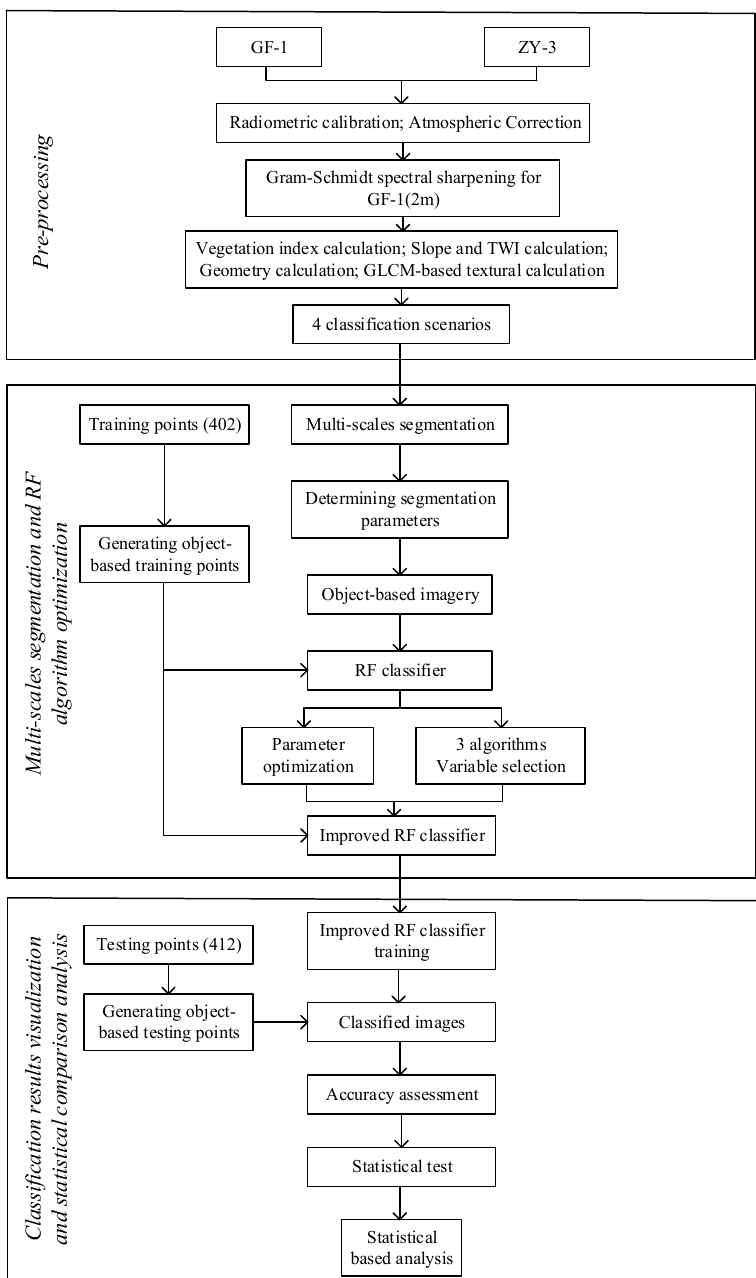
Figure 3. Methodological flowchart illustrating important steps to produce marsh vegetation